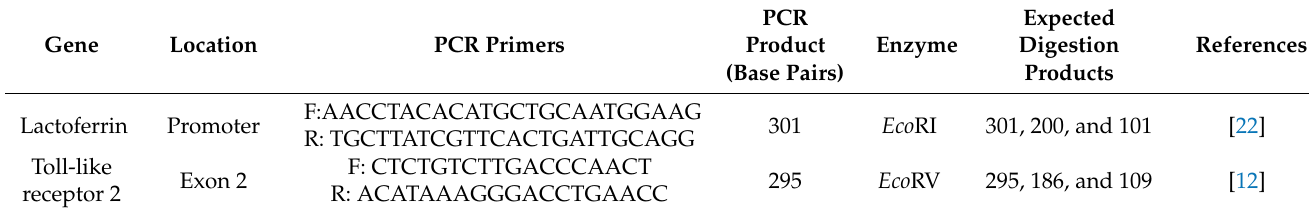
Table 1. PCR primers and expected product sizes for PCR